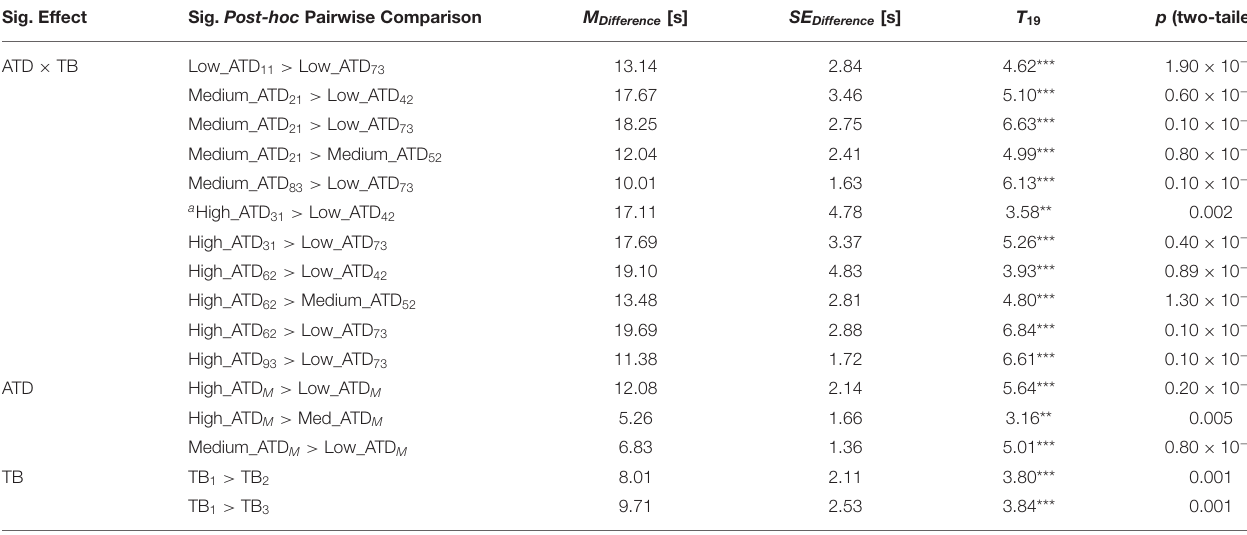
TABLE 5 | Post-hoc tests of significant interaction and main effects in the air traffic conflict detection task (AT-CDT). Sig.